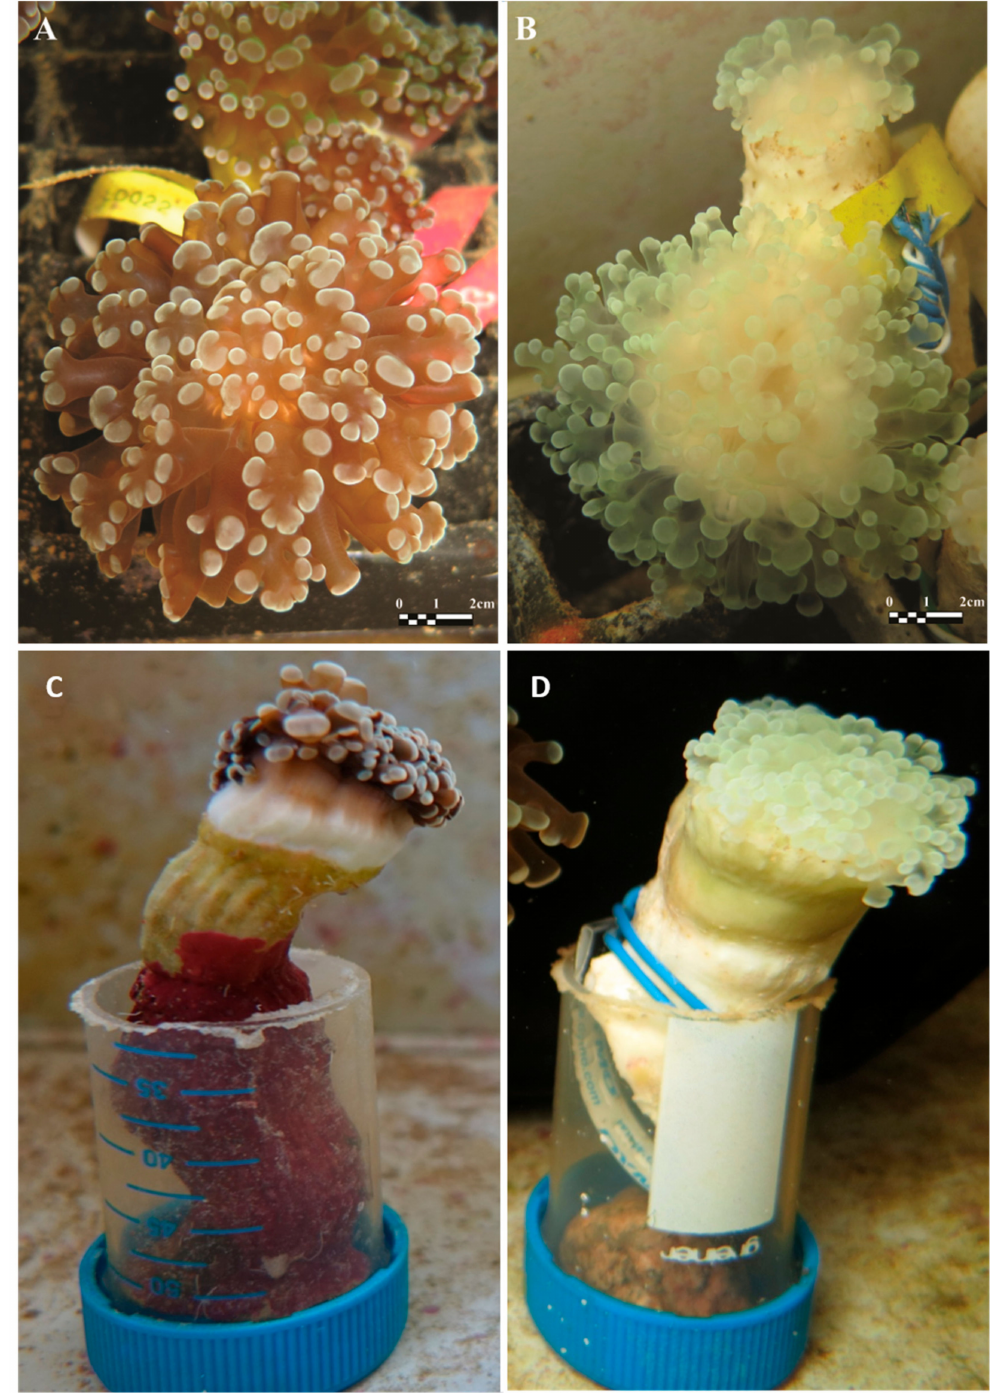
Figure 1. Euphyllia paradivisa sub-colonies showing a healthy symbiotic profile ( A , C ) and apo-symbiotic sub-colonies ( B , D ) after five months in the